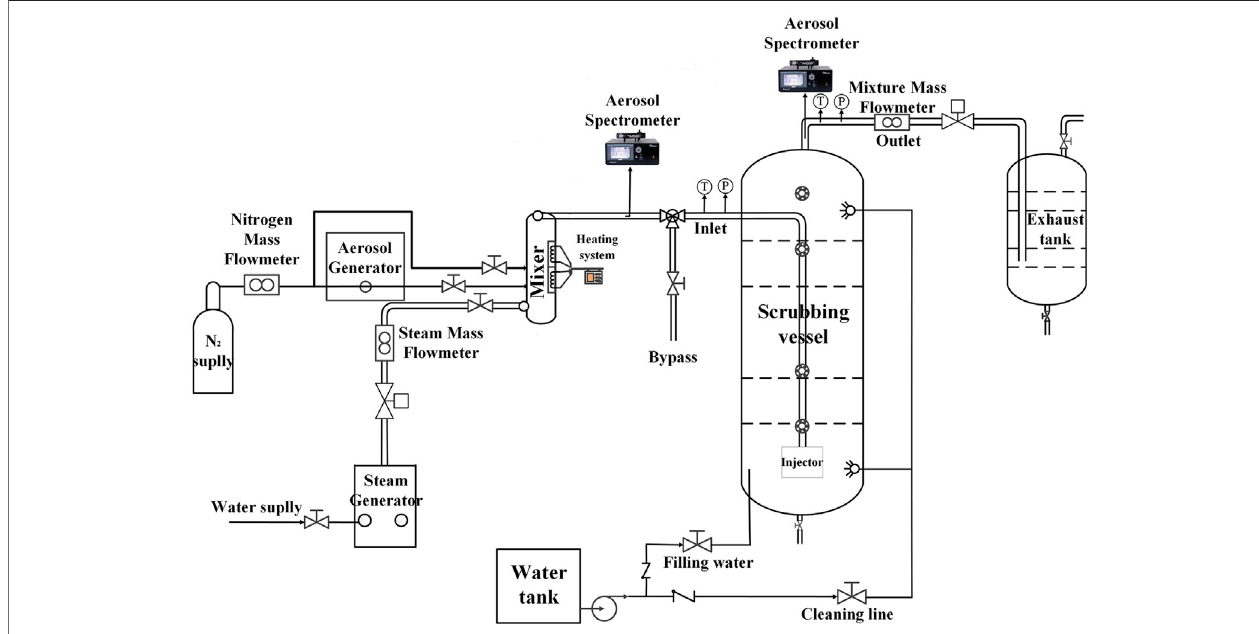
FIGURE 1 | Schematic diagram of the SAPOS test